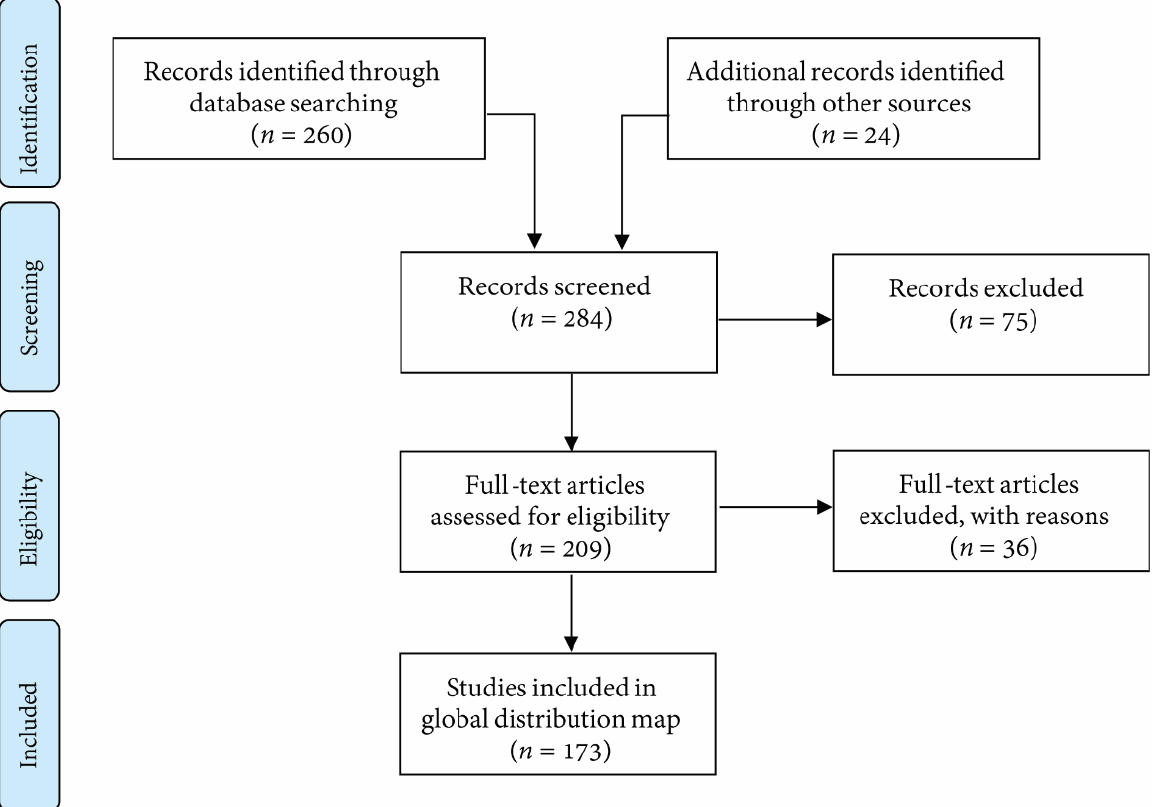
Figure 2. PRISMA flowchart of the systematic review papers screening process for creating the turbid reefs global distribution map.